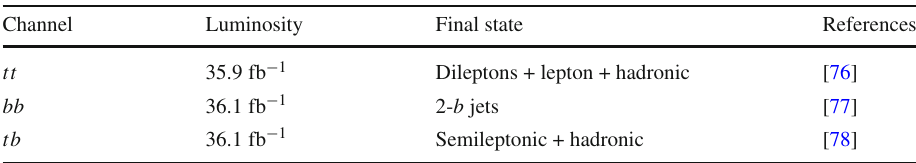
Table 3 The sources of the experimental upper bounds for the tt , bb , and tb channels we use in our